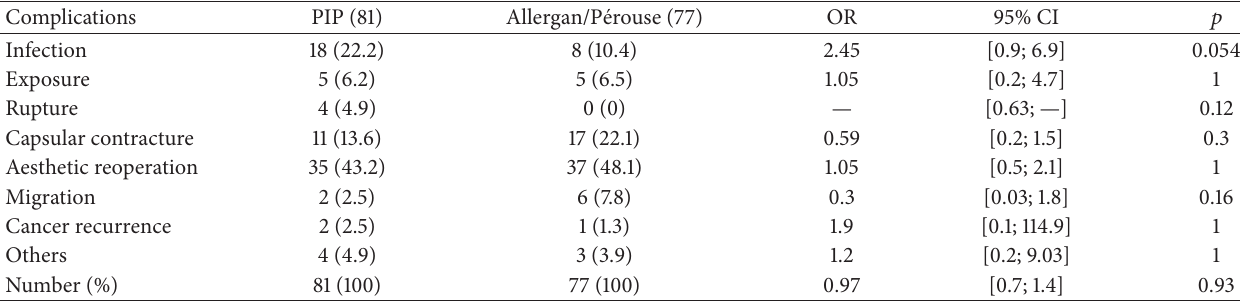
Table 1: Reasons for breast implant